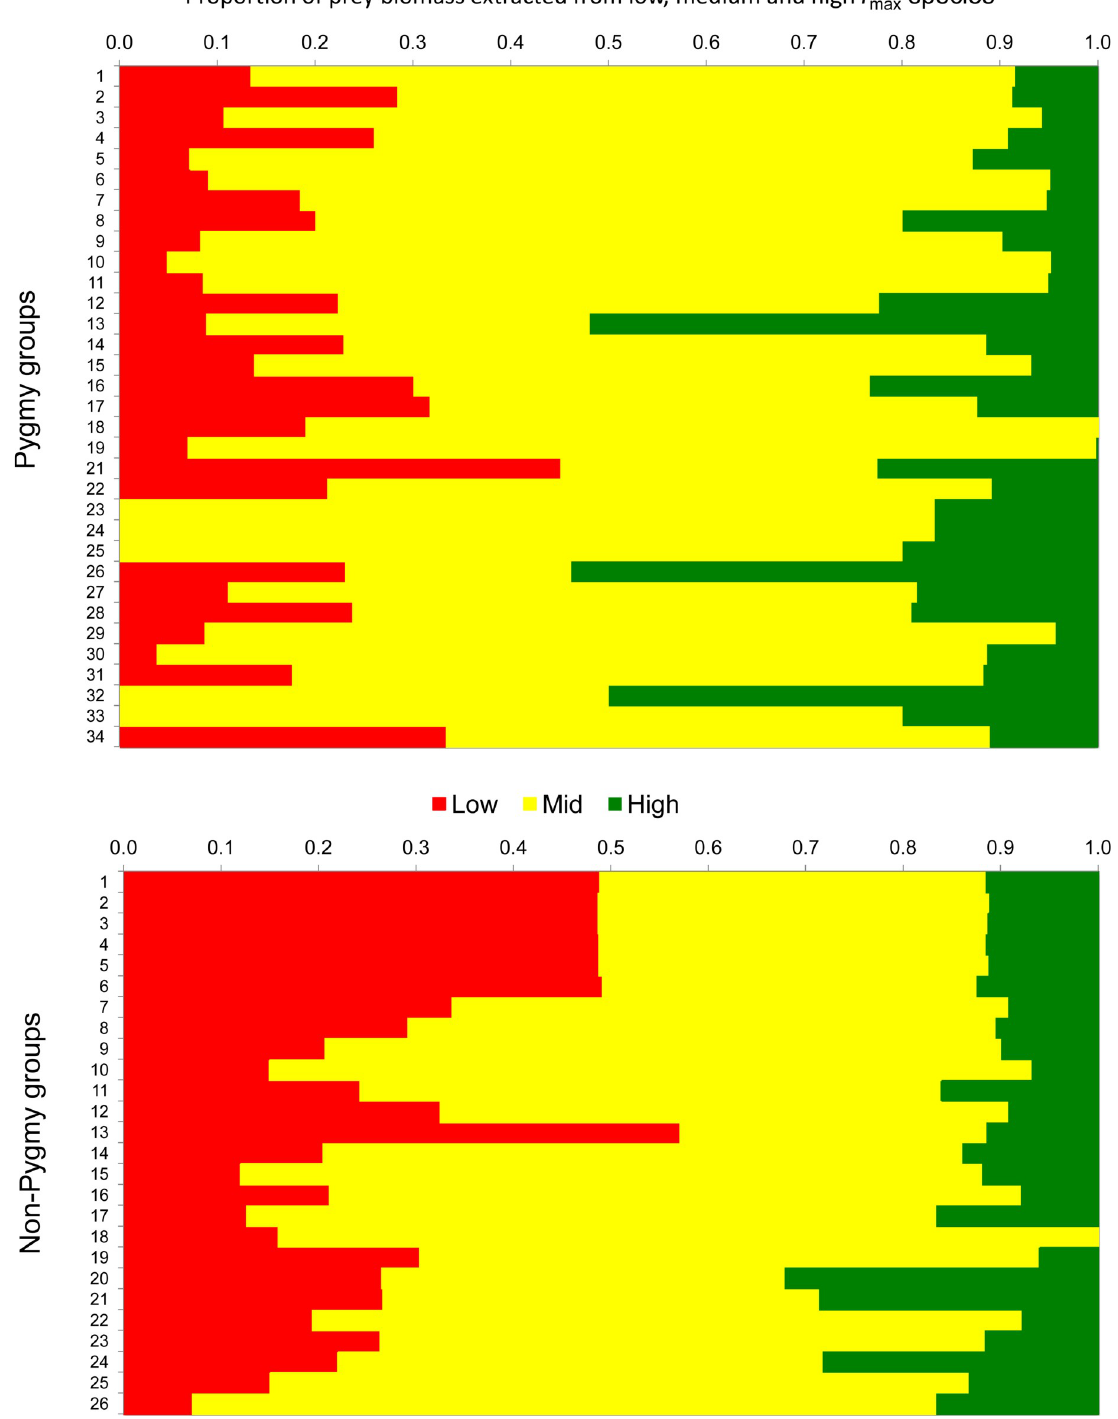
Fig 5. Stacked bar graphs, with sites sorted according to the numbering in Fig 1, of the percentage contribution made by mammals of low, medium and high species population growth rate ( r max ) that were hunted by Pygmies and non-Pygmies.